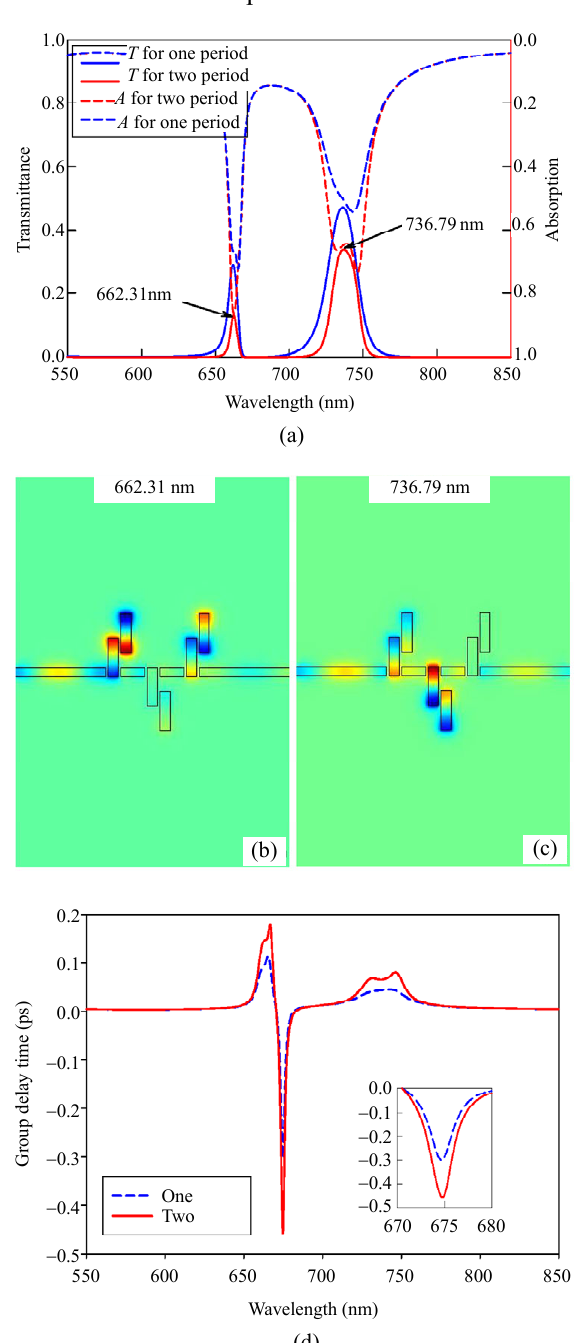
Fig. 7 Tansmission/absorption spectra: (a) and group delay time, (d) of the proposed device with one period (blue line) and two period (red line), and (b)  (c) H z field distribution corresponding to the wavelengths of 662.31 and 736.79